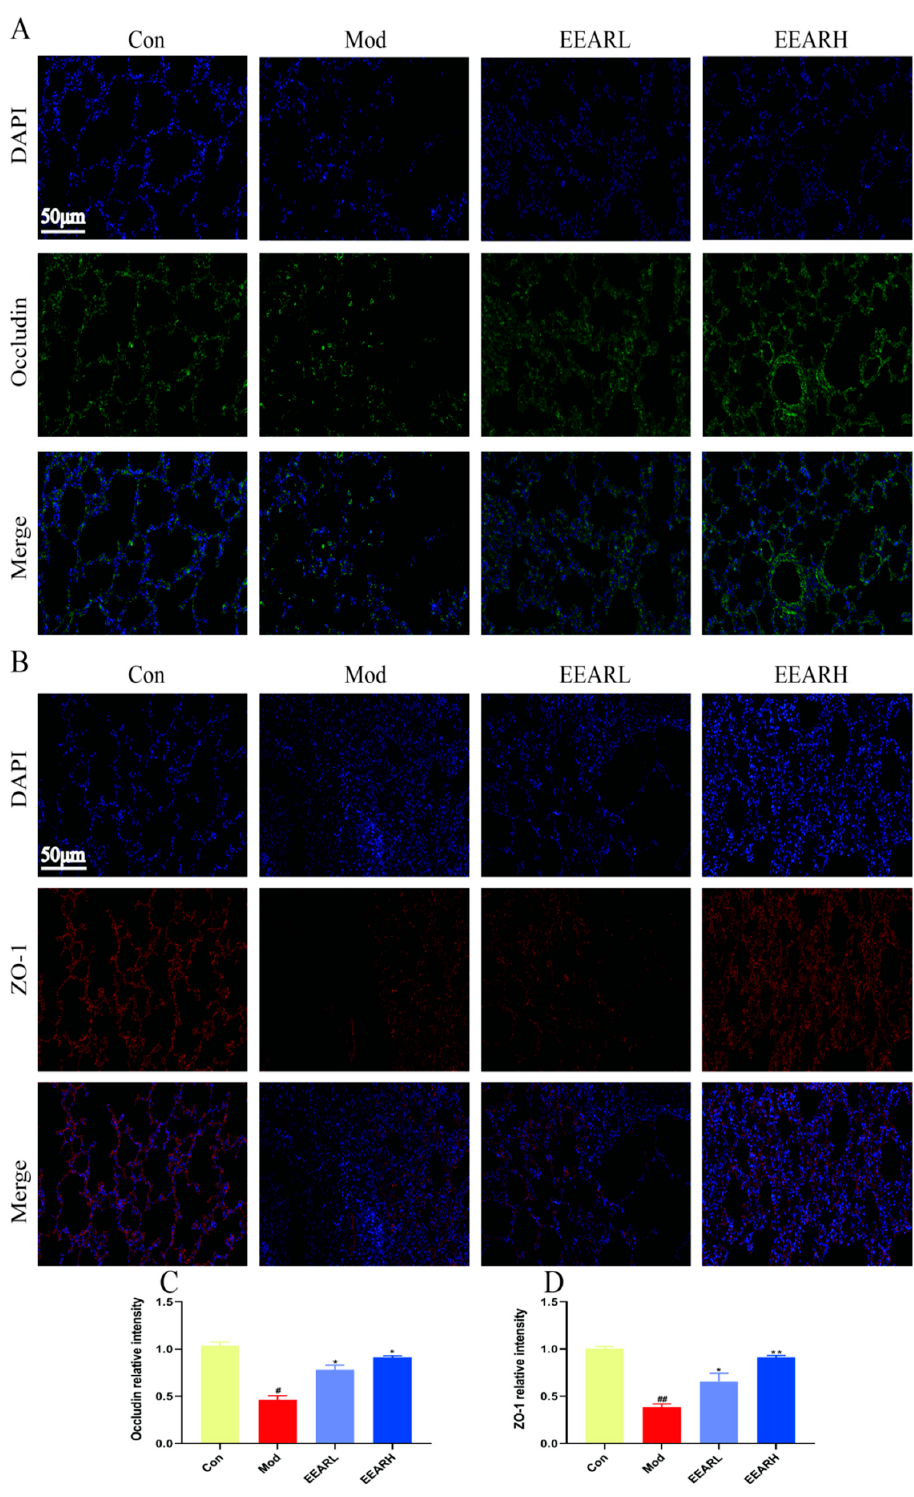
Figure 4. EEAR improved the lung epithelial barrier in rats with acute lung injury. ( A ) Immunofluorescence of the tight junction protein occludin in rat lung tissue. ( B ) Immunofluorescence of tight junction protein ZO-1 in rat lung tissue. ( C ) Plot of occludin levels ( n = 3). ( D ) Plot of ZO-1 levels ( n = 3). Values are expressed as means ± SEM. ## p < 0.01 vs. Control; # p < 0.05 vs. Control; ** p < 0.01 vs. Model; * p < 0.05 vs. Model.